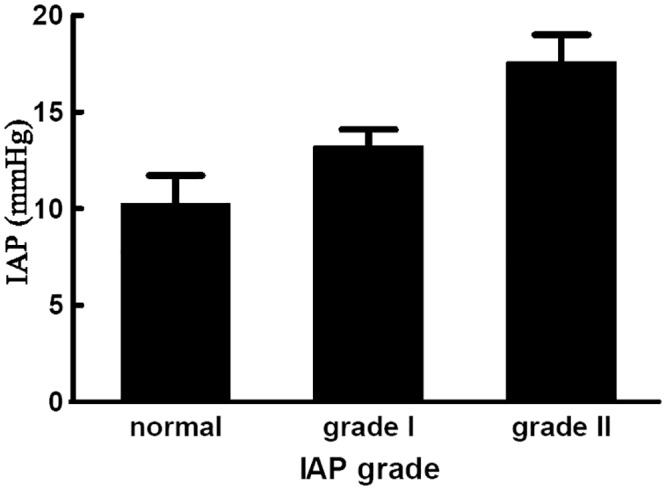
Bar chart representing the frequency of different grades of IAH according to the World Society for Abdominal Compartment syndrome guidelines.Normal: IAP<12mmHg; GradeI IAH: IAP between 12 to 15 mmHg. GradeII IAH: IAP between 16 to 20 mmHg. GradeIII IAH: IAP between 21 to 25 mmHg. GradeIV IAH: IAP greater than 25 mmHg. IAP: intra-abdominal pressure, IAH: intra-abdominal hypertension.